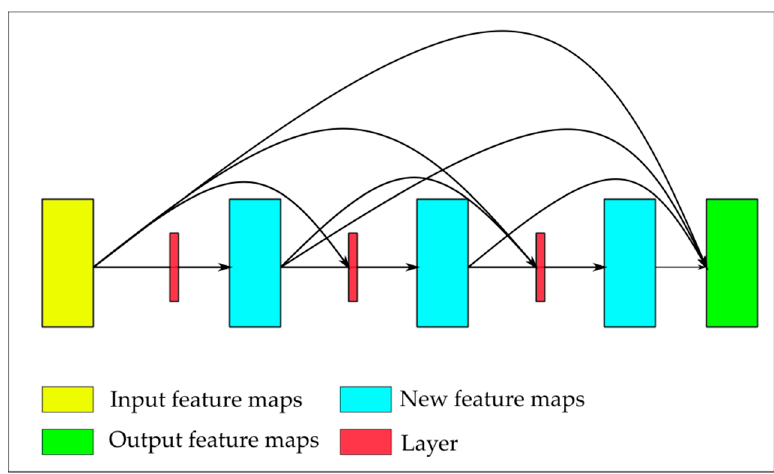
Figure 2. A dense block with three convolutional layers. The red blocks represent a layer in a dense block. Table 1. Layer composition in a dense block. Table 1. Layer composition in a dense